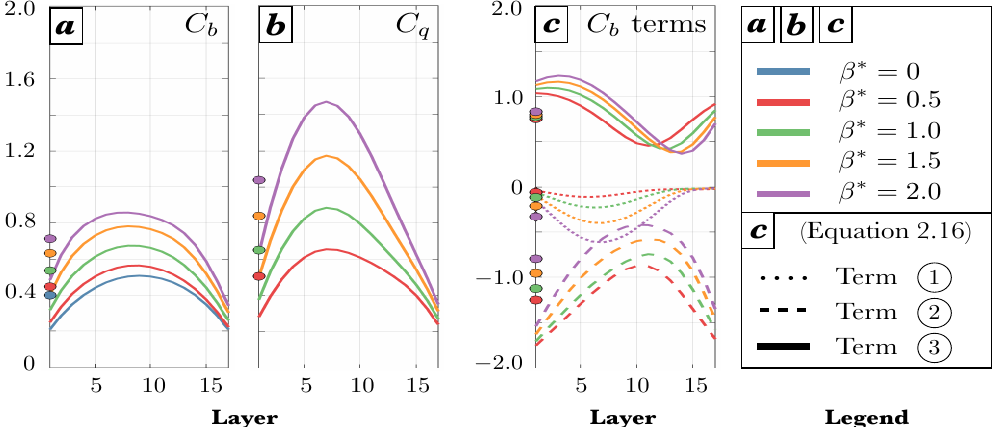
Figure 1. Values of ( a ) C b , ( b ) C q , and ( c ) the component terms of C b in (16), across the interior model layers. Mean values for each curve are shown by the dots on the left side of each